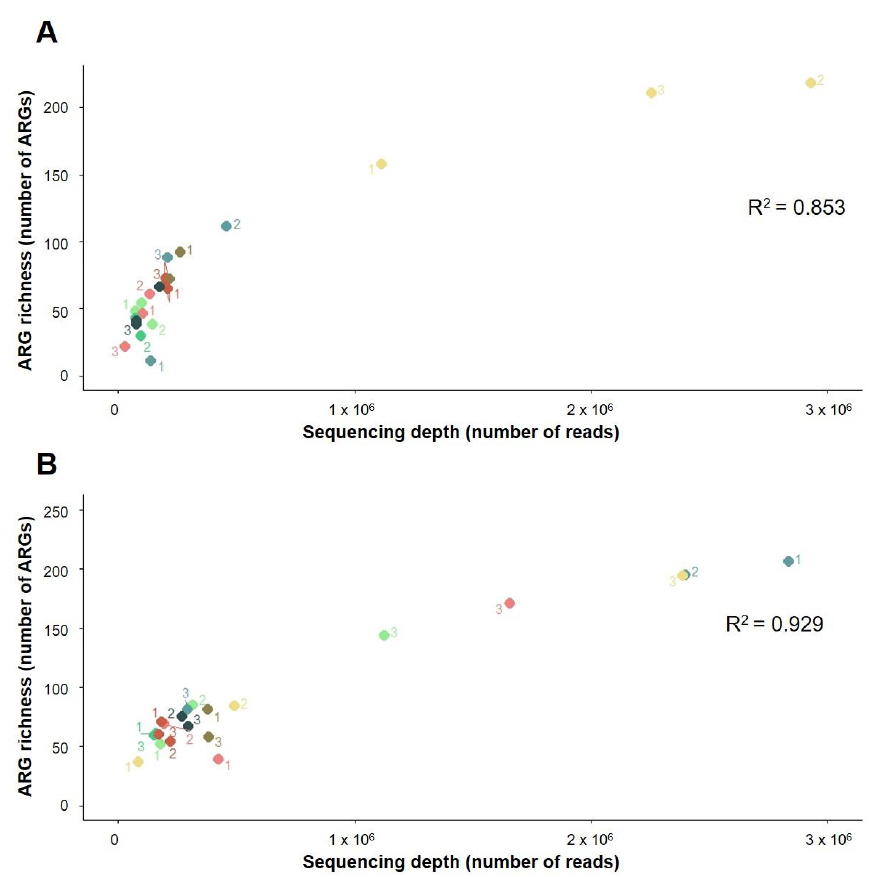
Figure 3. Effect of sequencing depth on the ARG richness discovery from ( A ) the Scottish Agricul- tural College soil (Craibstone, Scotland) and ( B ) La Côte de Saint André soil (France). Green: Maxwell 1 modification of the prototype Maxwell RSC Fecal Microbiome DNA Kit (Promega). Red: Maxwell 2 modification of the prototype Maxwell RSC Fecal Microbiome DNA Kit (Promega). Blue: Phenol/Chloroform. Yellow: DNeasy PowerSoil Kit (QIAGEN). The ARG richness measured in each sample was determined and plotted as a function of the sequencing depth. For each method/soil pair, triplicates (labelled 1, 2, and 3) were sequenced twice and plotted in the graph. Lighter colours repre- sent the first sequencing run, and darker colours represent the second sequencing run. Correlation p- value: 3.37 × 10 −1 0 (Scottish Agricultural College soil) and 2.35 × 10 −1 2 (La Côte de Saint André soil).